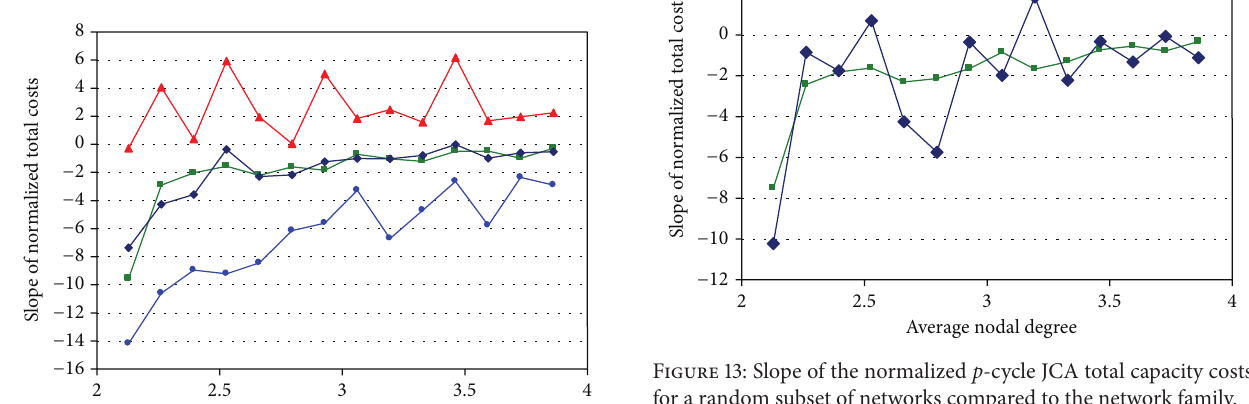
Figure 10: Slope of normalized span restoration JCA total capacity costs.